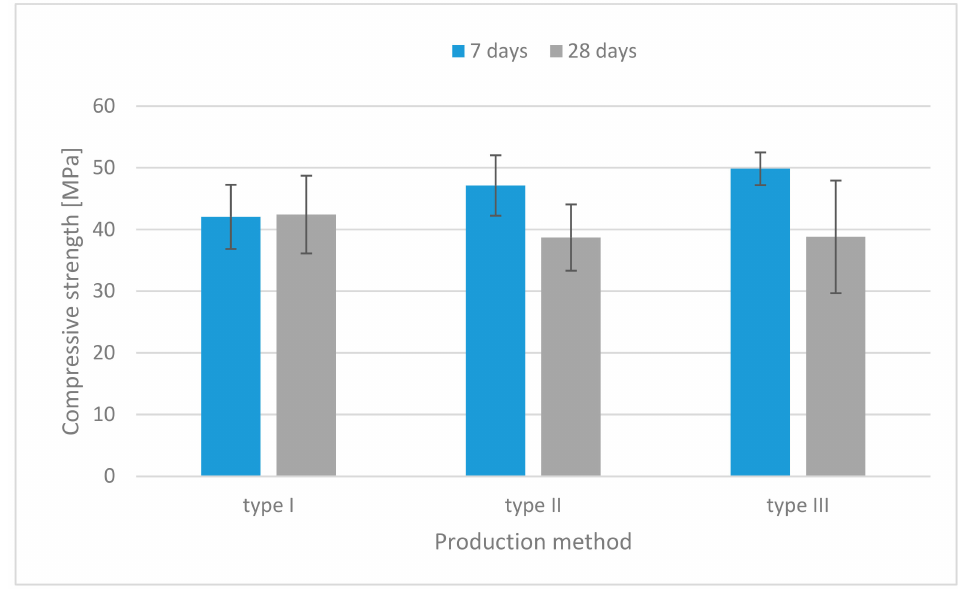
Figure 5. Compressive strength histograms (specimens containing carbon